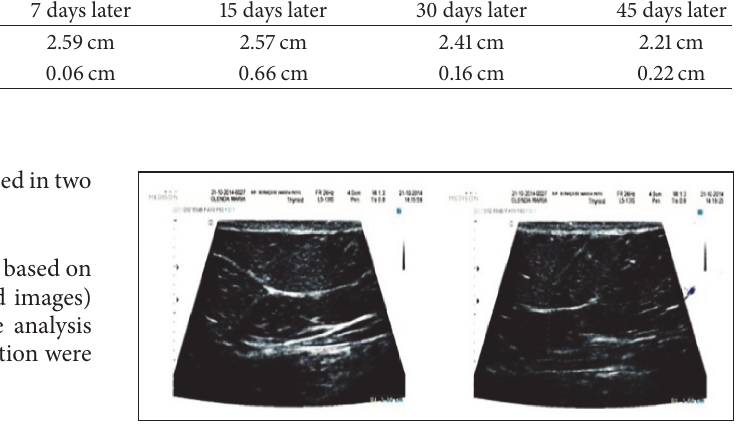
Figure 3: Sonography before treatment.